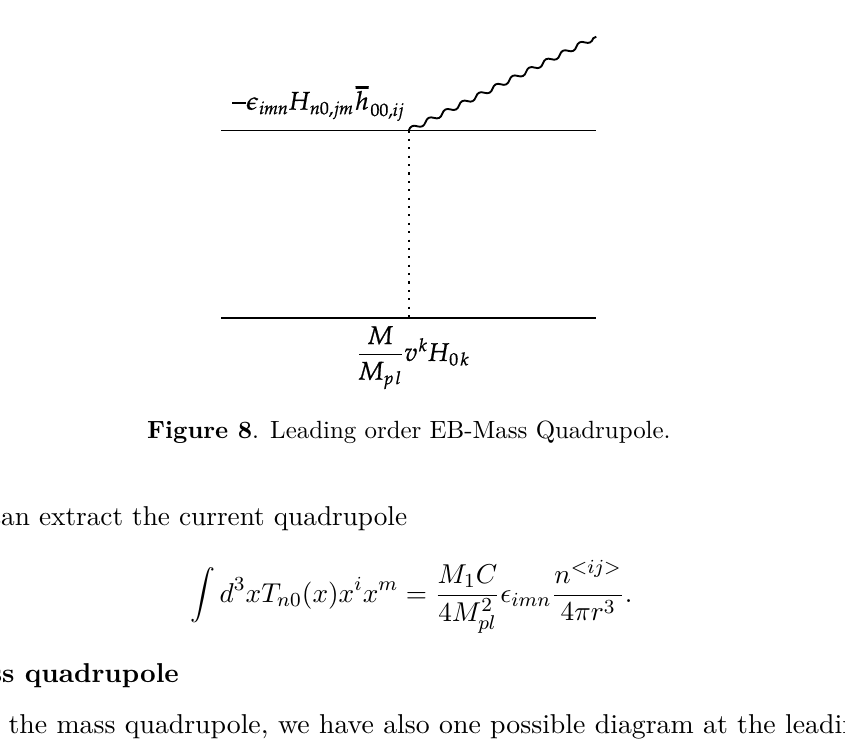
Figure 7 . Leading Order EB-Current Quadrupole.